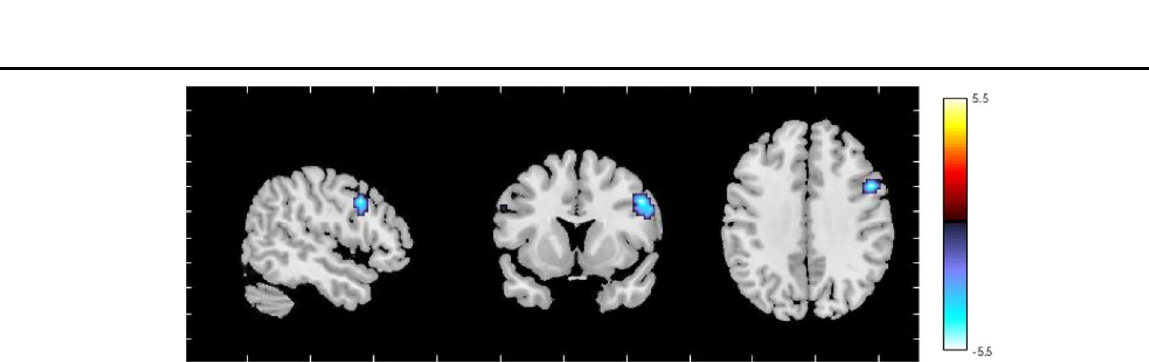
emotional task. Given our a priori hypothesis on the role